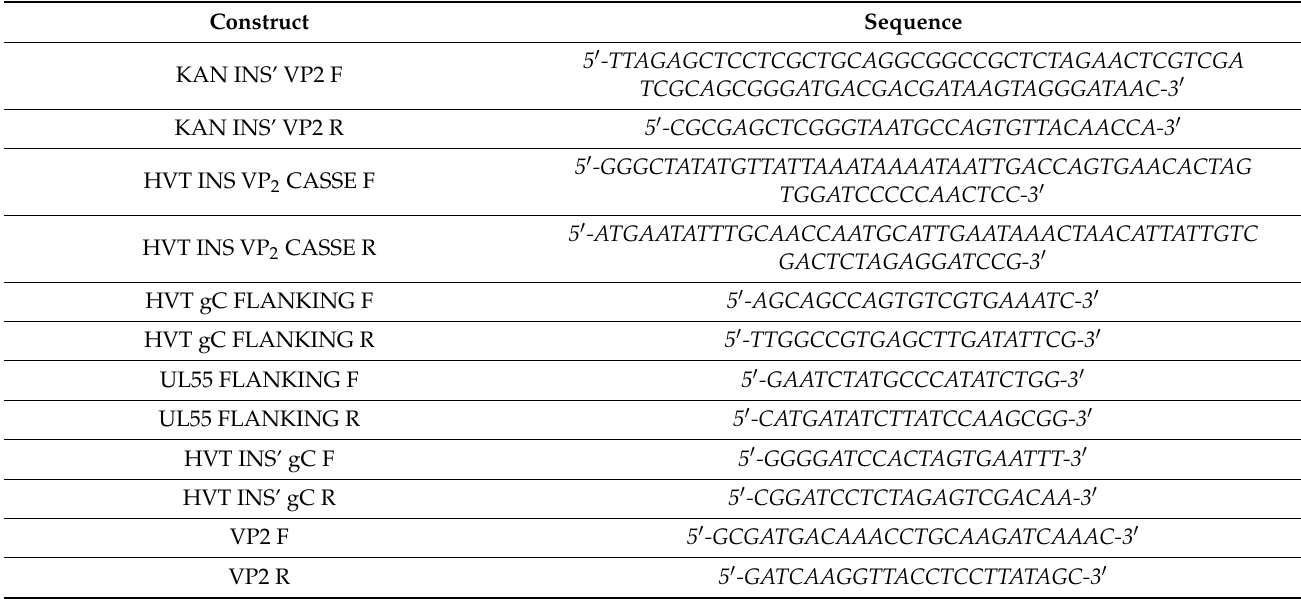
Table 1. PCR amplification using specific